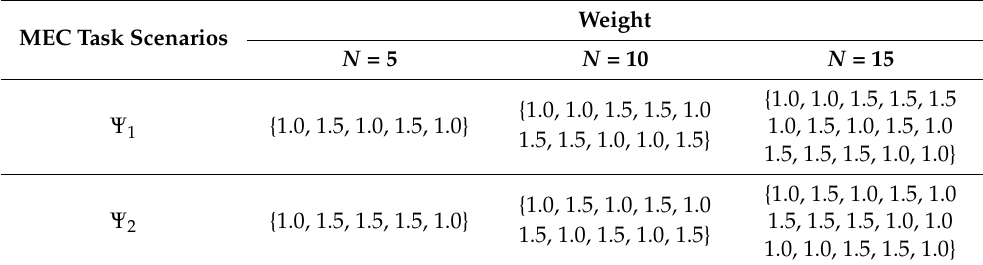
Table 3. Weight factors of different WDs.